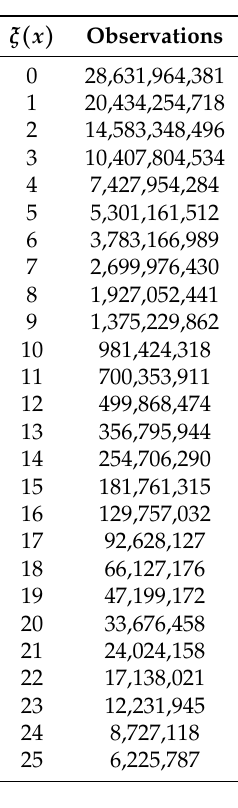
Table A1. Distribution of inflation propensity ξ ( x ) for the first 1 × 10 11 integers. ξ ( x